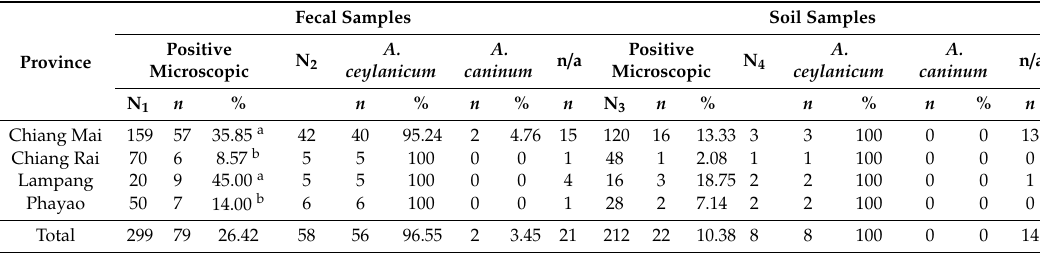
Table 1. Summary of hookworm infection in dog fecal samples and soil samples in Thailand, as demonstrated by the microscopic results and subsequent PCR-RFLP targeting the ITS